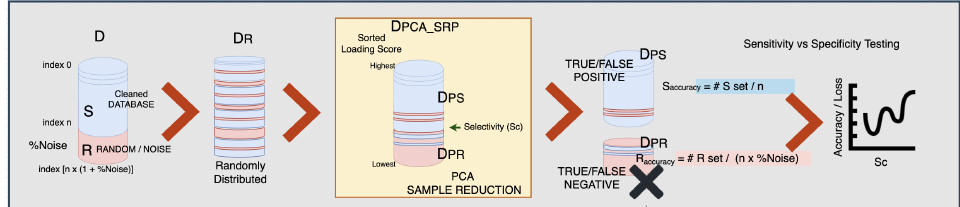
Figure 9. Detailed sensitivity vs. specificity testing